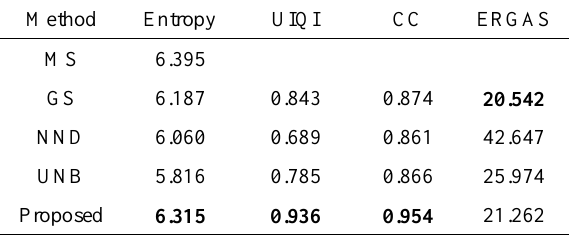
Table 3. Quality evaluation of fused images: Urban (corresponding to Figure 3). The best performance of each metric is in bold.